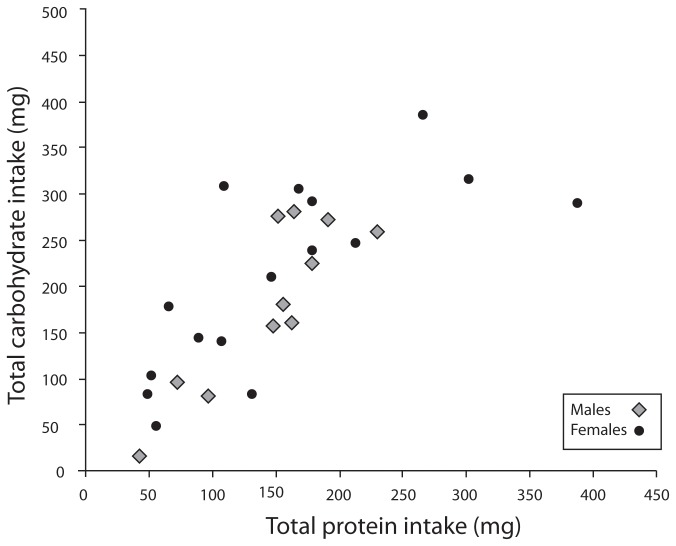
Carbohydrate and protein intake in individual male and female Hemideina crassidens, shown by sex, over a seven night experimental trial period after weta were captured from the wild.